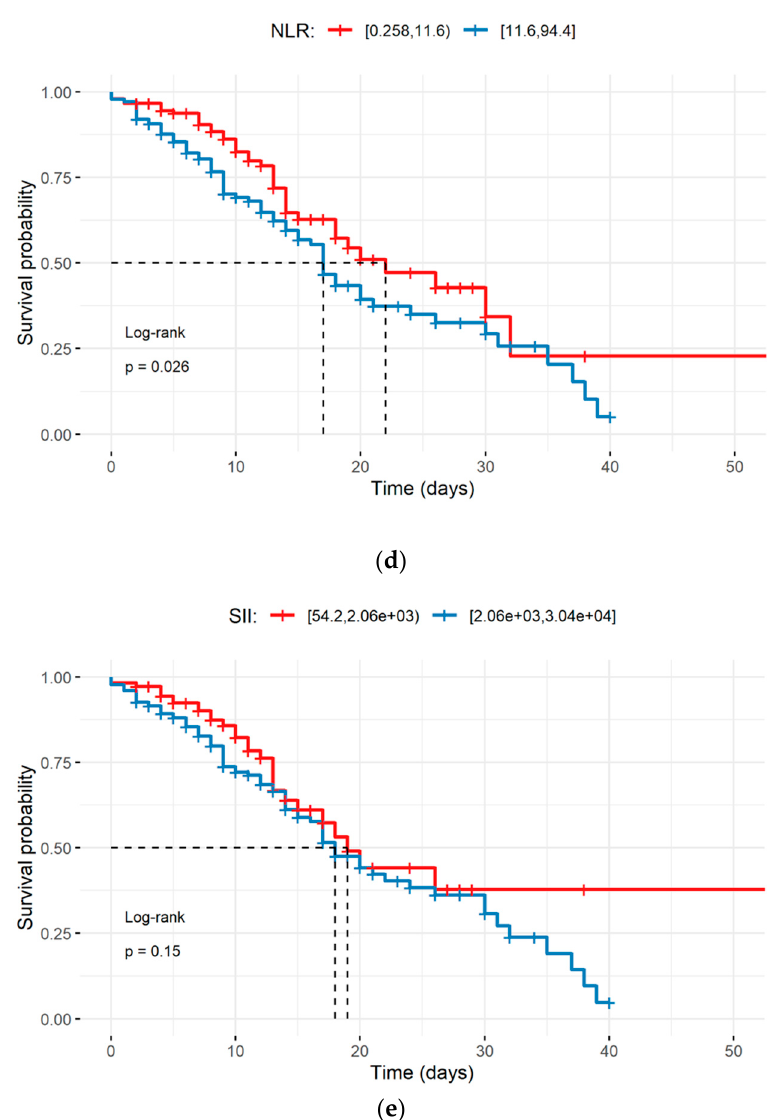
Figure 1. Kaplan-Meier survival curves during hospitalisation of COVID-19 patients with different cut-off values of the age and systemic inflammation markers: ( a ) age; ( b ) C-reactive protein; ( c ) procalcitonin; ( d ) the neutrophil–lymphocyte ratio; ( e ) the systemic immune inflammation index. The dotted line designates median survival. The survival comparison was performed using the log-rank test. Table 6. Univariate and multivariate Cox model analysis.